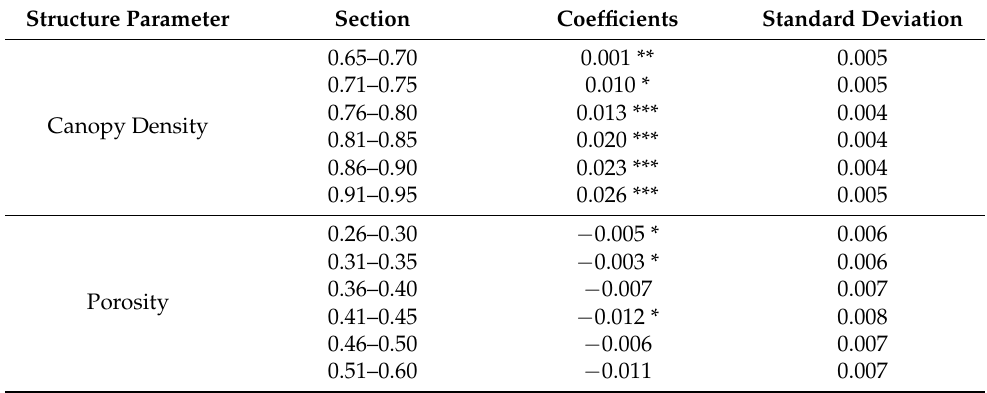
Table 3. Regression analysis on canopy density, porosity, vegetation type, and humidifying volume. Structure